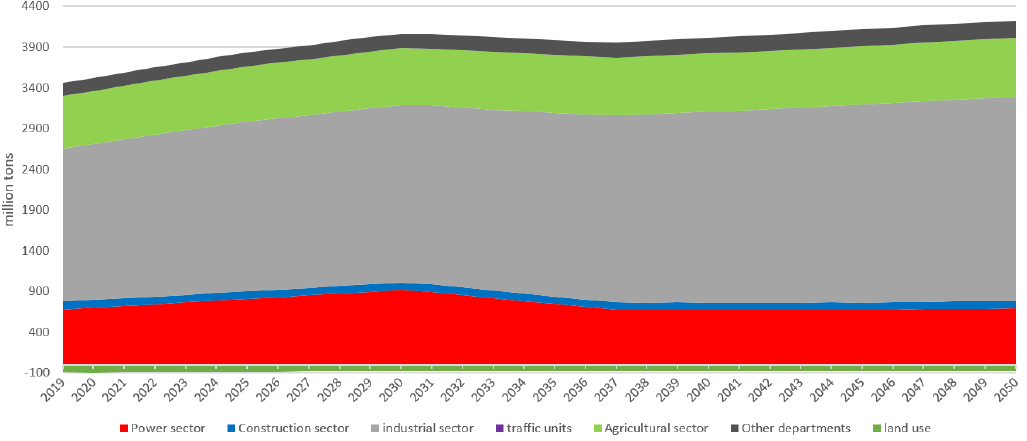
Figure 7. Change of carbon dioxide emissions in Inner Mongolia under the baseline scenario.